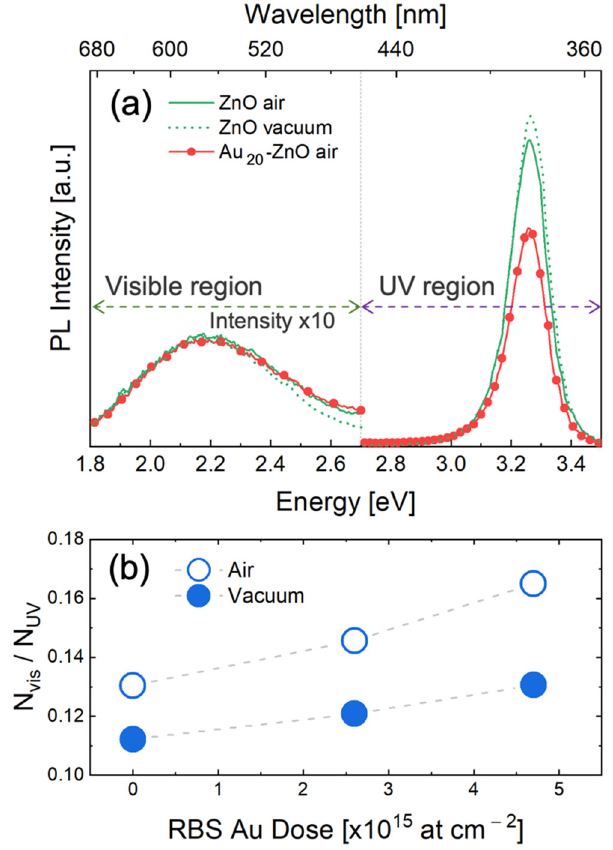
Figure 2. ( a ) PL spectra of bare ZnO (green continuous line) and Au 20 -ZnO (red and dotter line) in air, and bare ZnO in vacuum (green dotted line), with visible emission multiplied by a factor of 10; ( b ) ratio between the intensity of visible ( N vis ) and UV emission ( N UV ) in air and in vacuum versus Au NP-decoration extent.